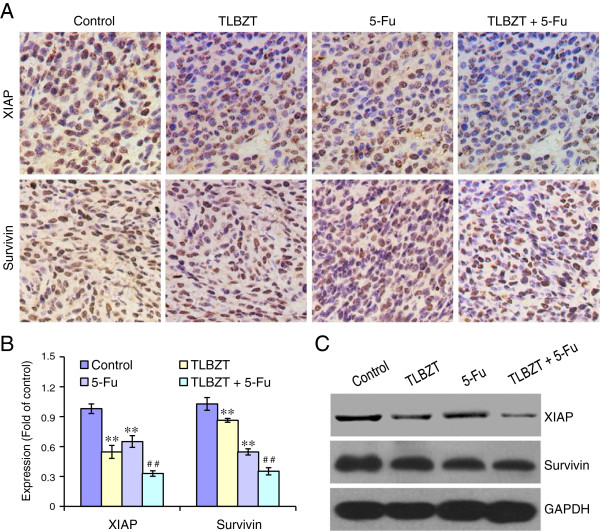
Effects of TLBZT and 5-FU on XIAP and Survivin expression. After three weeks treatment, expression of XIAP and Survivin in CT26 carcinoma (3 tumors/group) were detected by immunohistochemistry and observed under microscope (×200) (A). The mean optical density (MOD) of XIAP and Survivin (3 HPF/slide) were analyzed by Image-Pro Plus 6.0 software, and expressed as fold of control (B). C, expression of XIAP and Survivin in CT26 carcinomas were further verified with western blot by specific antibody. GAPDH was used as a loading control. **P<0.01, versus control group, ##P<0.01, versus TLBZT or 5-Fu group.